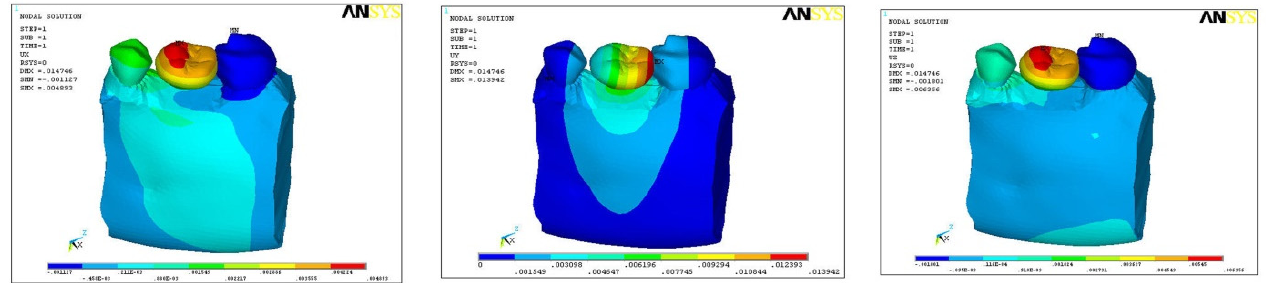
Figure 5. Direction of force in model B1.